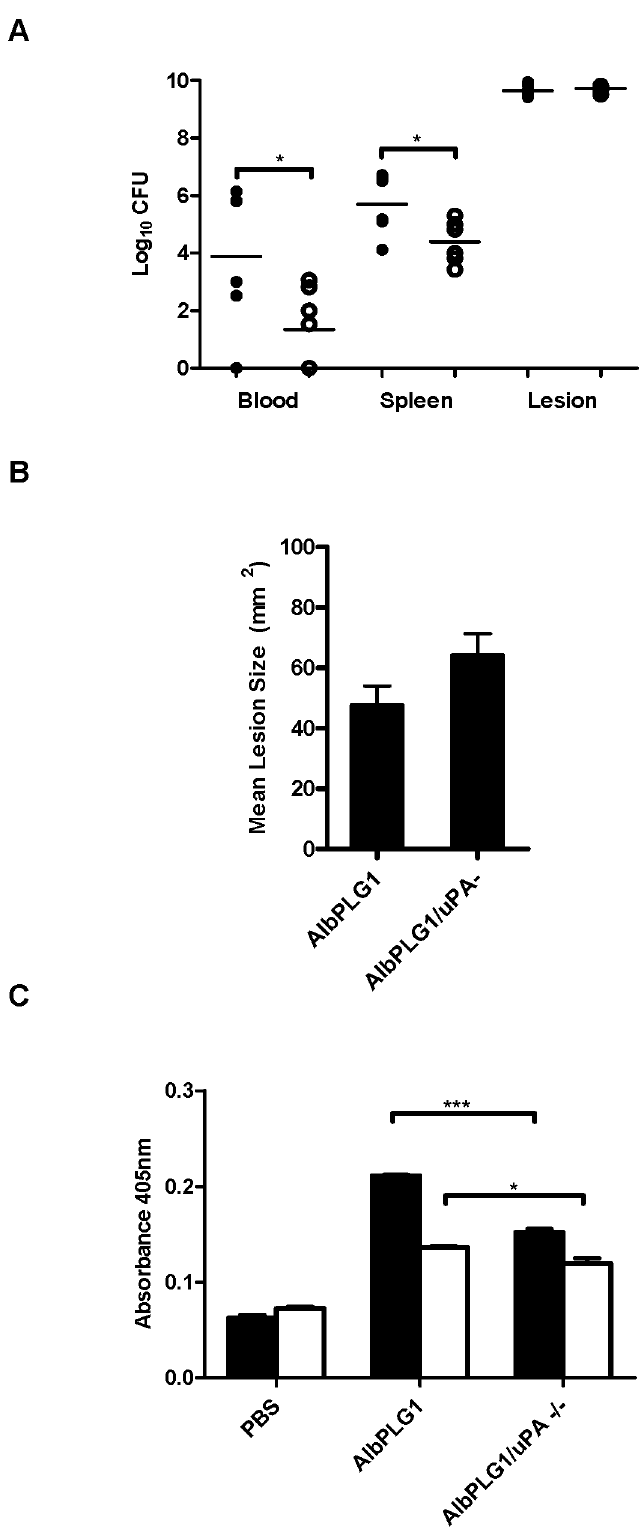
Figure 4. Bacterial dissemination invivo correlates with uPA mediated plasmin acquisition. A Bacterial counts in the bloodstream and spleen of mice were significantly higher in AlbPLG1 mice (black circles) than in AlbPLG1/uPA 2 / 2 mice (white circles). B AlbPLG1 and AlbPLG1/uPA 2 / 2 mice develop equivalent lesions 3 days post-inoculation with GAS strain 5448. C GAS strains 5448 (black fill) and 5448 D ska (no fill) accumulate significantly lower levels of cell surface plasmin ex vivo in AlbPLG1/uPA 2 / 2 compared with AlbPLG1 plasma. Dissemination and lesion size data is combined from 3 independent experiments ( n =6). Plasmin acquisition data is representative of two independent experiments, error bars indicate SEM ( n =3). Asterisks indicate statistical significance as determined by unpaired two-tailed students t-test, P , 0.05 (*), P , 0.001. doi:10.1371/journal.ppat.1003469.g004 PLOS Pathogens | www.plospathogens.org 7 July 2013 | Volume 9 | Issue 7 |